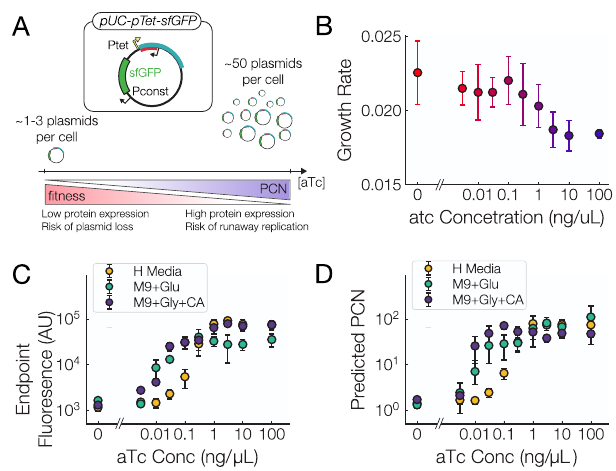
Fig. 2 Control of gene expression through induction of plasmid copy number. A Schematic of the effects of adding aTc to the pUC-pTet-sfGFP plasmid. As the concentration is increased the number of plasmids and sfGFP genes increases as well as the metabolic cost of the plasmid. B Growth rates of cells hosting the pUC-pTet-sfGFP plasmid as a function of aTc concentration. C sfGFP Production of the pUC-pTet-sfGFP plasmid grown at different aTc concentrations. D Estimated plasmid copy numbers from sfGFP measurements of our plasmids. We see that the copy number induction curve shifts towards lower aTc concentration as with decreasing media richness. For all panels, Data points are means over biological replicates, error bars = std. dev. ( n =